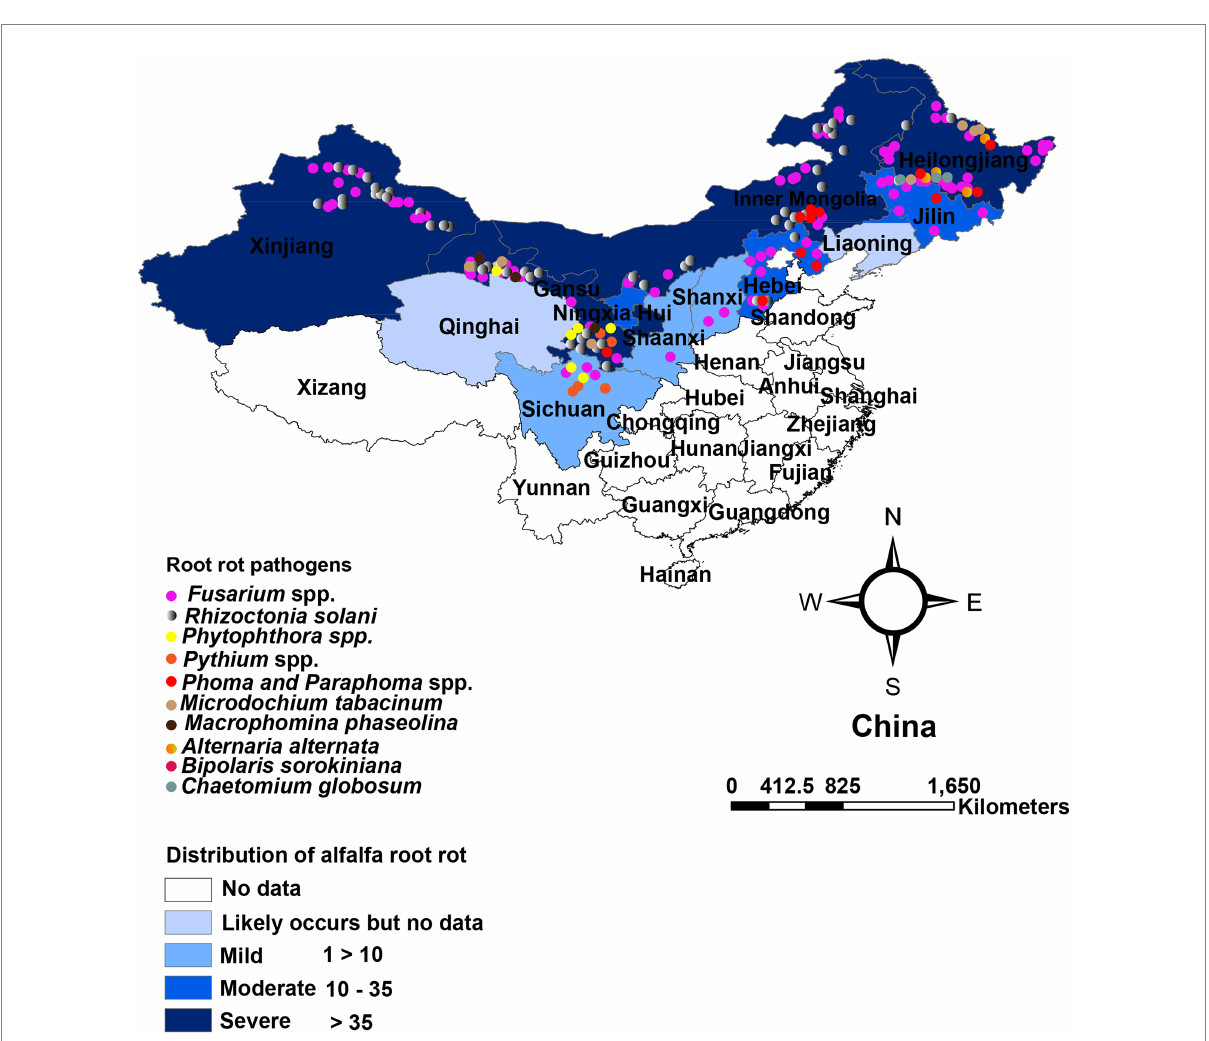
FIGURE 1 Geographical distribution and affected region in China. Color depth indicates affected provinces, and dots indicate root rot pathogens based on China Academic Journals full-text database (CNKI), Web of sciences (WoS), and other